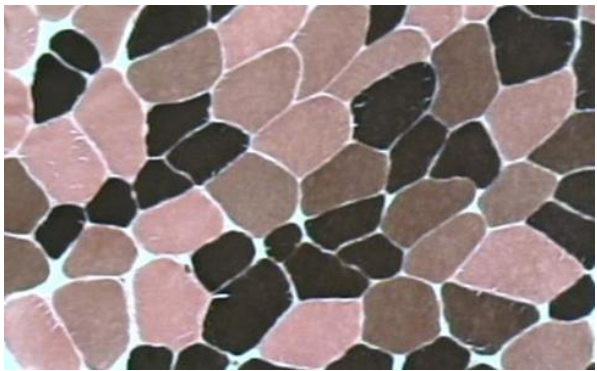
Figure 2. Myosin ATPase staining of a cross-section from vastus lateralis muscle of an elite hammer thrower (80.45 m best performance), preincubated at pH 4.6 and post-stained with eosin. Type I fibers appear as dark grey, type IIA fibers appear as moderate grey and type IIX fibers appear as light violet. Selective hypertrophy of type II fibers is obvious. Some small-sized type I fibers are shown